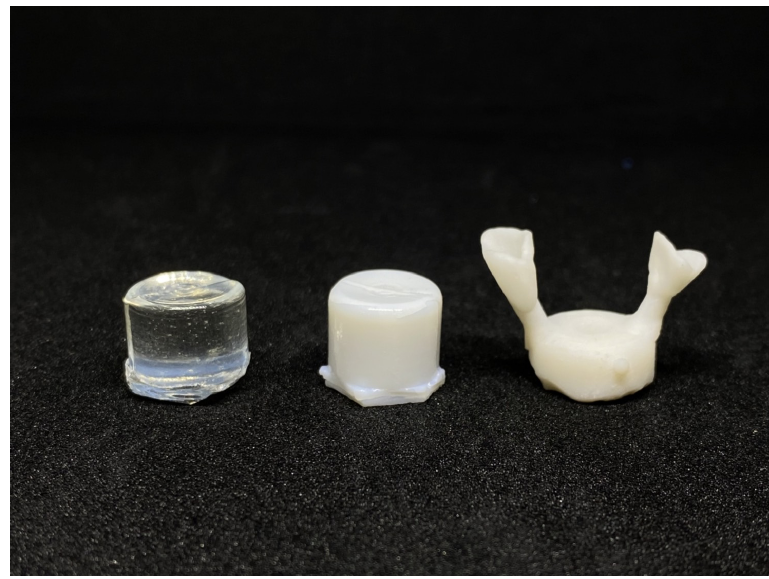
Figure 10. The LSA3 sample before heating ( left ), the LSA3 sample heated at 600/800 °C and the completely pressed object ( right ).